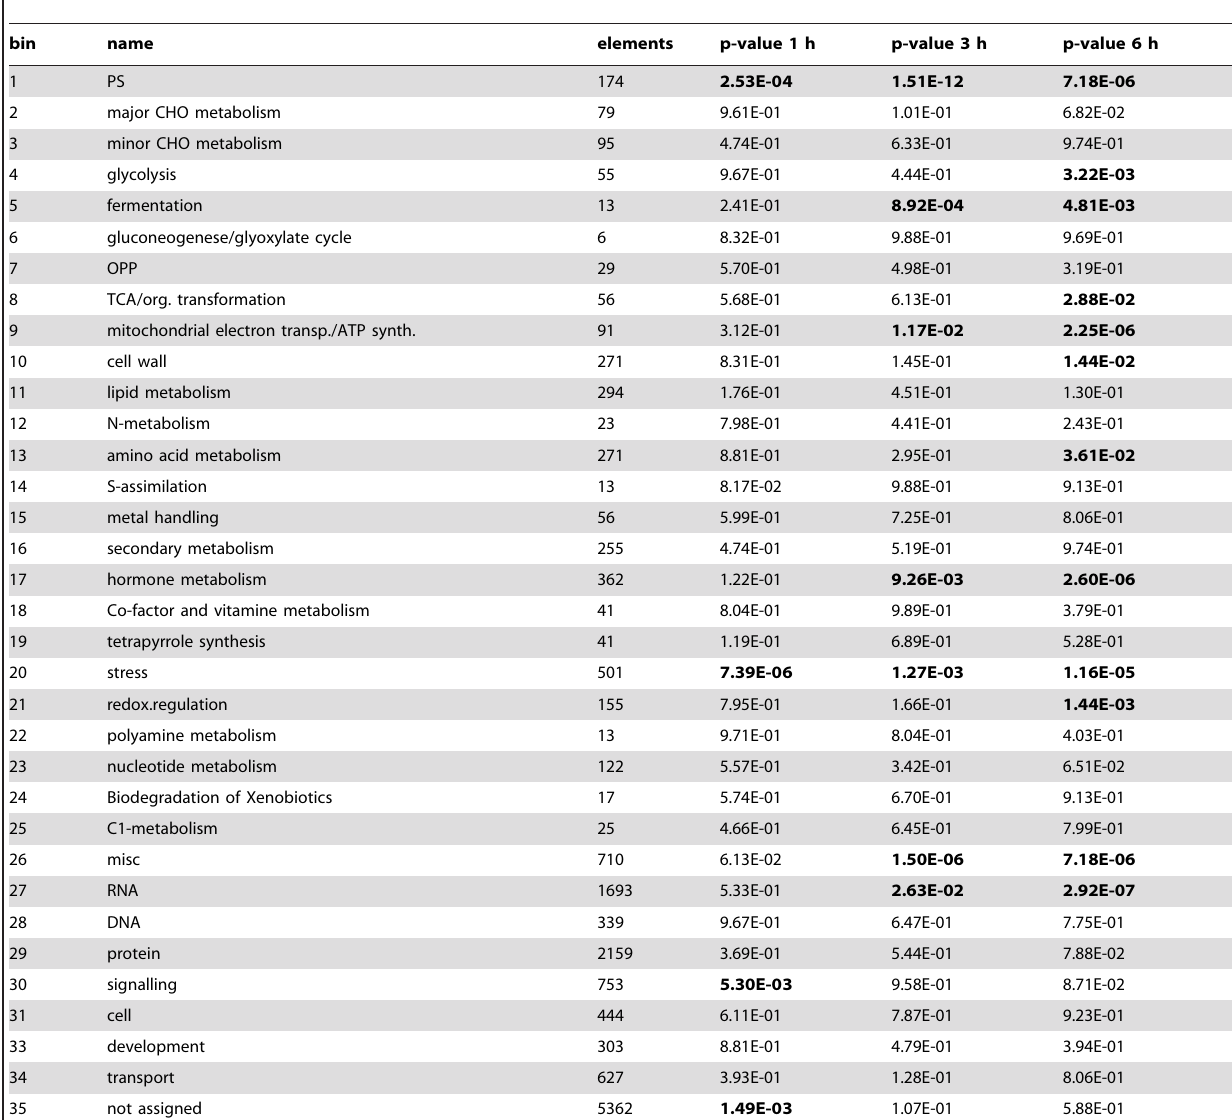
Table 2. Gene representation of functional classes differentially expressed upon MeJA treatment calculated by M AP M AN .